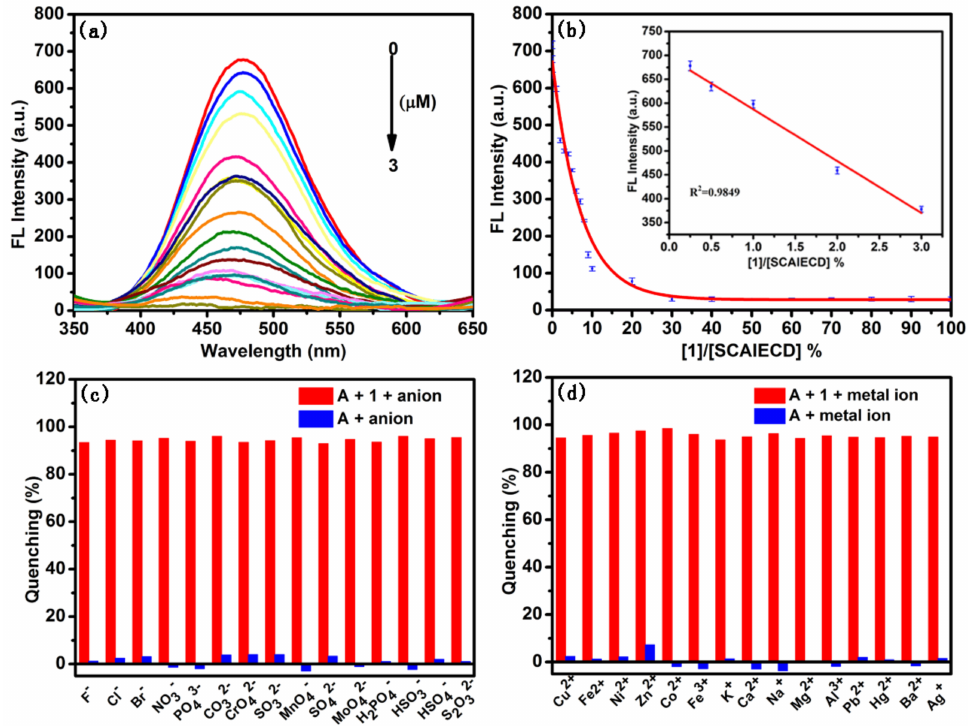
Figure 5. ( a ) Fluorescence emission spectra of SCAIECD (5 µ M) exposed to various concentrations of 1 (0, 0.001, 0.01, 0.05, 0.1, 0.2, 0.3, 0.4, 0.5, 0.6, 0.7, 0.8, 0.9, 1, 1.5, 2, 2.5, and 3 µ M from top to bottom); ( b ) fluorescence titration curve of SCAIECD with the hydrogenase of 1 , the inset shows the fluorescence response at low hydrogenase concentrations; ( c ) percentage fluorescence quenching of SCAIECD (5 µ M) with different metal ions and the hydrogenase of 1 (red bars), percentage fluorescence quenching of SCAIECD (5 µ M) only in the presence of different metal ions (blue bars); ( d ) percentage fluorescence quenching of SCAIECD (5 µ M) with different anions and the hydrogenase of 1 (red bars), percentage fluorescence quenching of SCAIECD (5 µ M) only in the presence of different anions (blue bars). Note: DMSO/H 2 O, 70/30, v / v ; λ ex = 330 nm, ex/em slits = 5/5. A represents